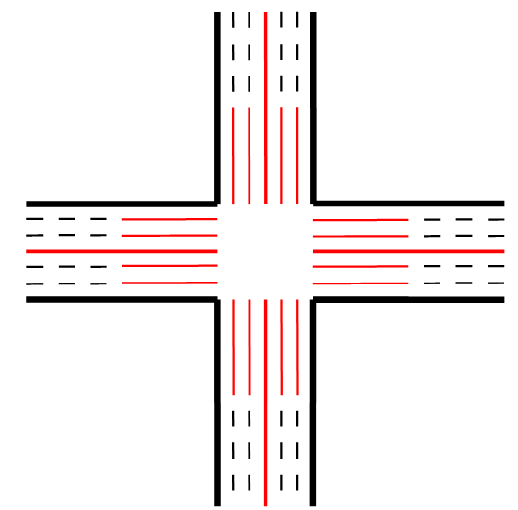
Figure 12. Visualization of intersection with multiple lanes (taken under consideration during work algorithm of proposed on algorithm of proposed solution) .